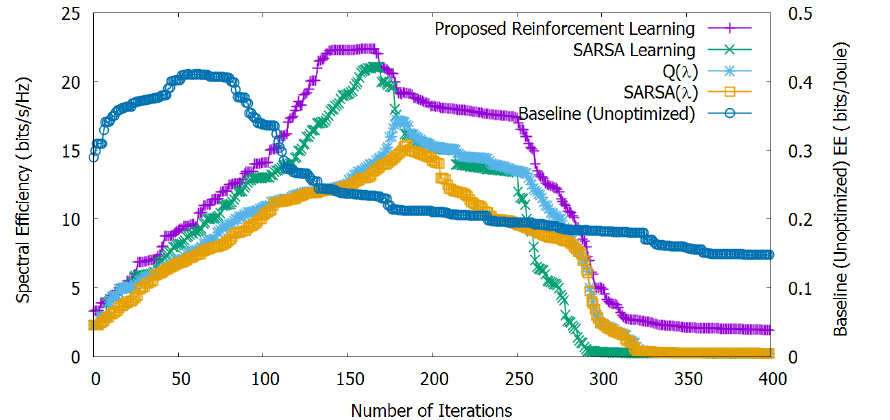
Figure 5. Stand-alone spectral efficiency performance evaluation and unoptimized energy efficiency. Spectral efficiency optimized by means of the proposed method remains maximized for a longer time as compared to the baseline technique; it decreases after approximately 170 iterations due to the increasing number of depleted UEs.